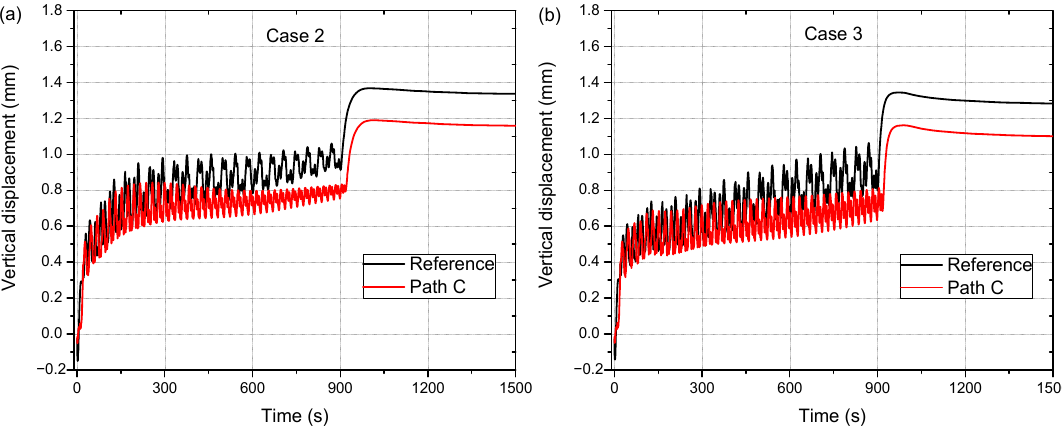
Figure 13. Comparison of the displacement evolutions of point DS1 between the reference and path C: ( a ) Case 1; ( b ) Case 2.